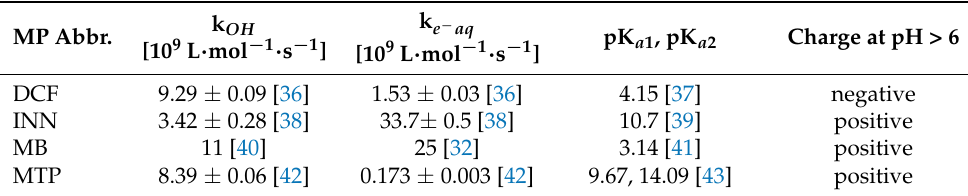
Table 2. Summary of relevant physicochemical properties of the selected MPs. MP Abbr.